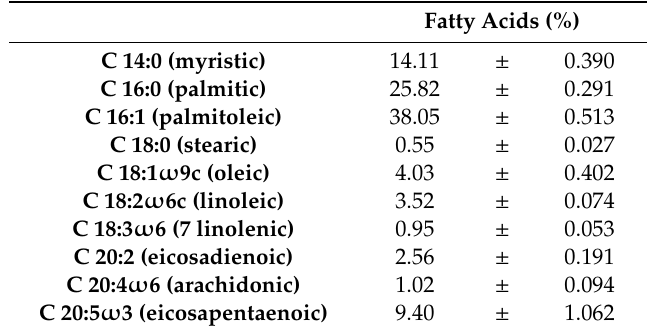
Table 1. Fatty acid profile of H. coffeaeformis . Percentage fatty acid composition of the neutral lipid fraction of H. coffeaeformis . The table shows average values ± standard deviation (n = 3). Fatty Acids (%)